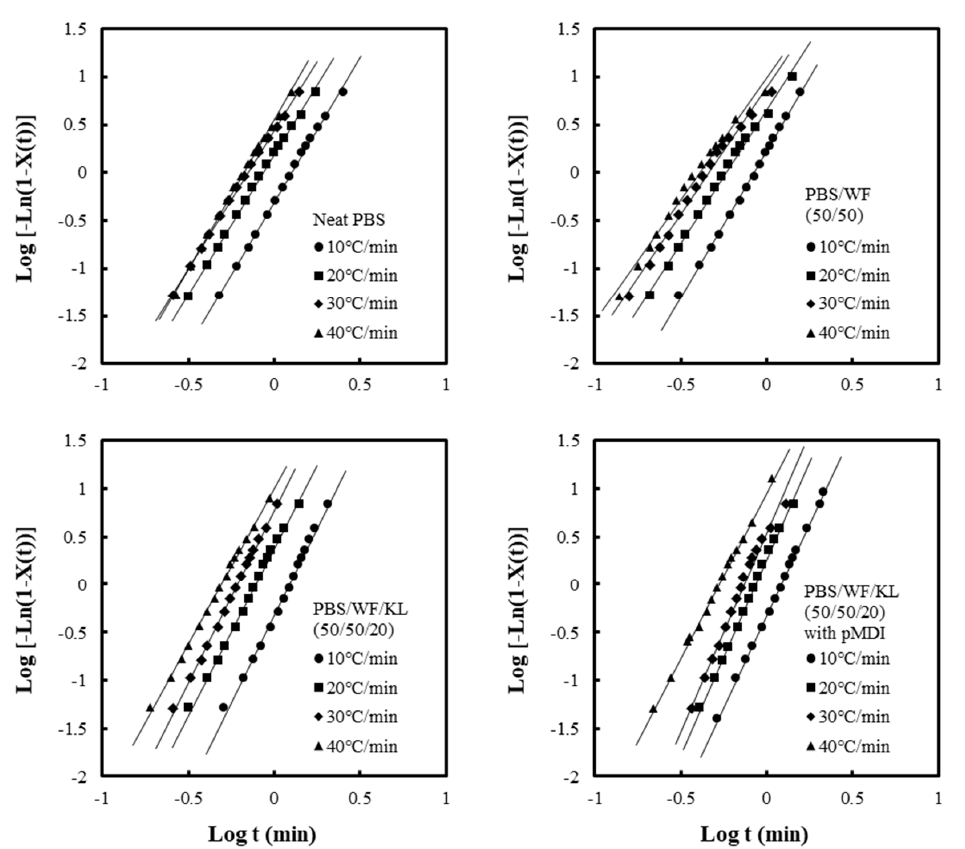
Figure 10. Avrami plots of log[1 − ln(1 − X(t))] versus log t for neat PBS, PBS/WF (50/50), and PBS/WF/KL (50/50/20) with and without pMDI at different cooling rates.